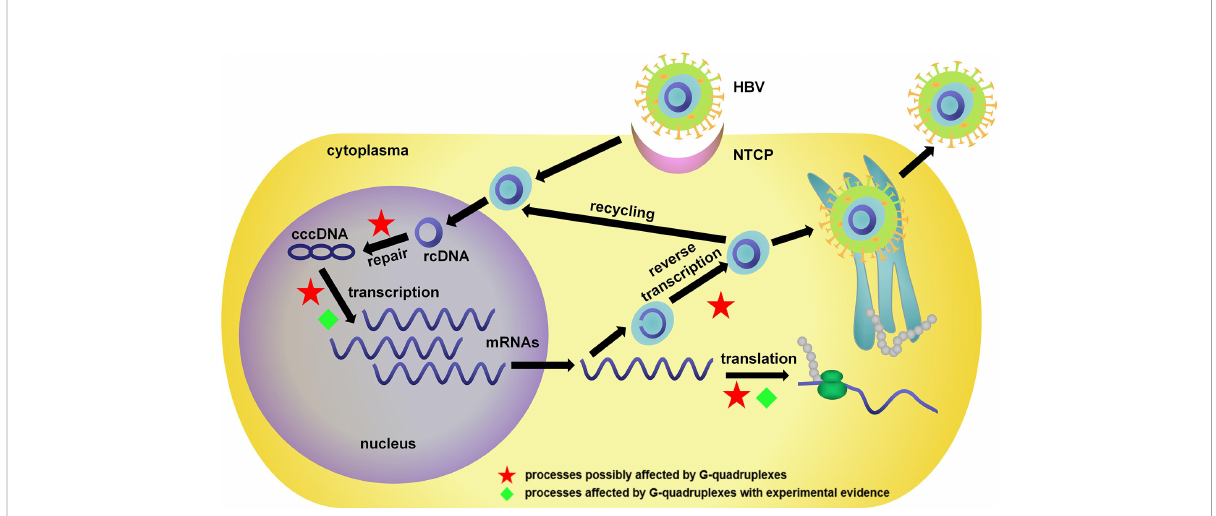
FIGURE 3 Life cycle of HBV and related bioprocesses possibly affected by G4s. NTCP, sodium taurocholate cotransporting polypeptide; rcDNA, relaxed circular DNA; cccDNA, covalently closed circular